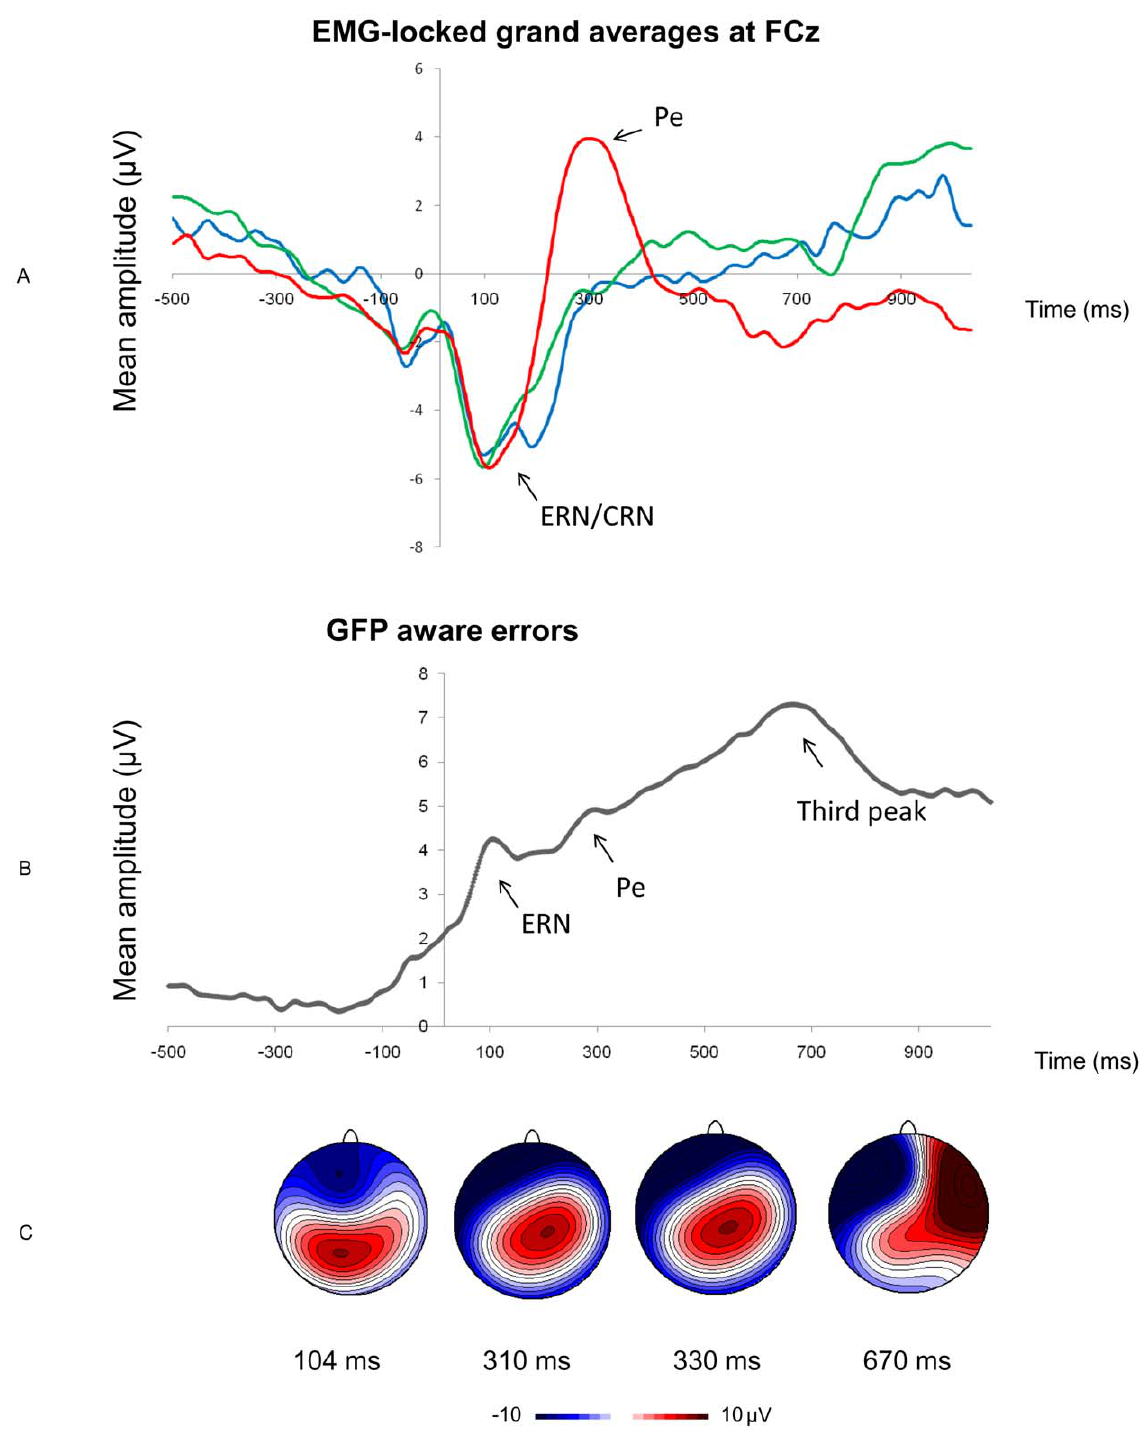
Figure 3. EMG-locked grand averages and global field power. (A) The EMG-locked grand averages displaying the mean amplitude at FCz for aware errors (red), unaware errors (blue), and hits (green) as a function of time. (B) The global field power for aware errors revealed 3 peaks corresponding with the timing of the ERN, Pe, and a later peak around the time of error verification (at roughly 100, 300, and 670 ms). Corresponding horizontal voltage topographic maps are presented (C). For the Pe, the topography of the early (310 ms) and late phase (330 ms) are shown.